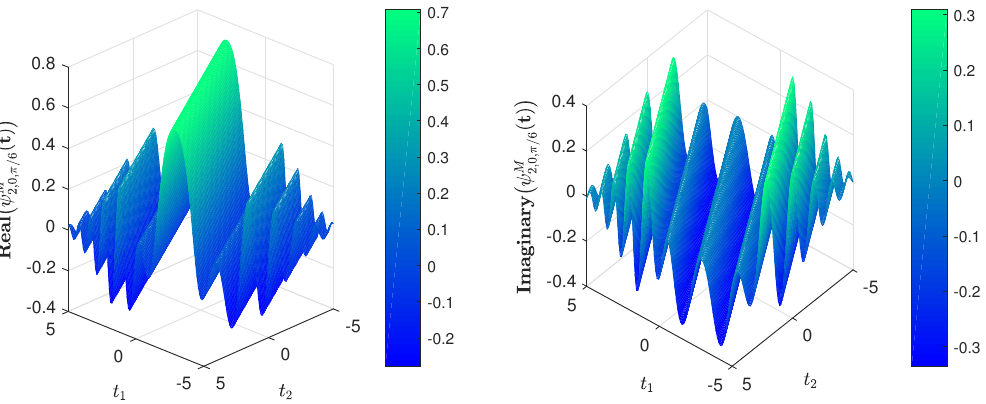
Figure 4. The linear canonical ridgelet waveforms for M = ( 1/4,1/6; − 3,2 ) at scale a = 2, location b = 0, and orientation θ = π /6.